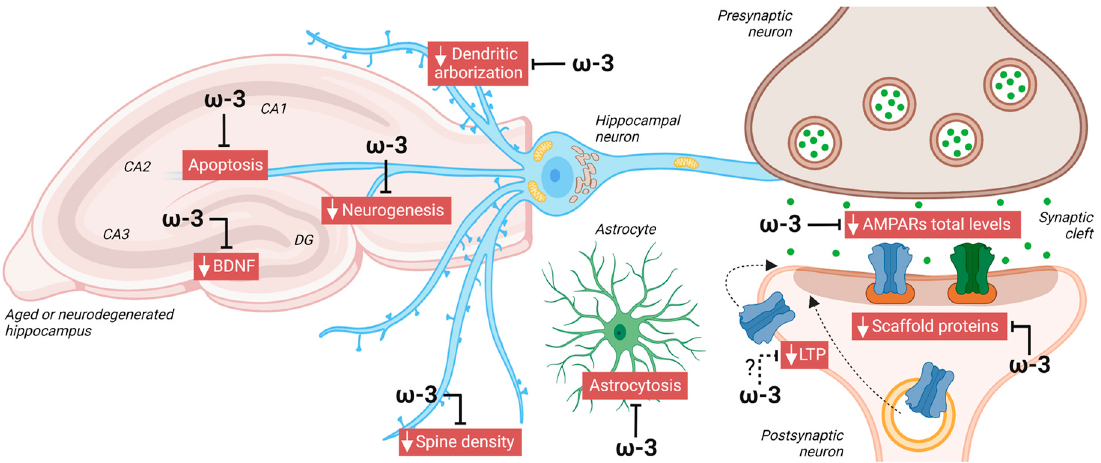
Figure 2. Protective role of omega 3 ( ω -3) against neurodegeneration. In animal models of aging or neurodegeneration, diet supplementation with ω -3 reduced apoptosis and astrocytosis, and enhanced neurogenesis, dendritic arborization, spine density, and levels of BDNF, AMPARs, and scaffold proteins, like postsynaptic density protein 95 (PSD95), in the HPC. The fact that ω -3 deficiency reduced LTP in aged mouse CA1-HPC suggests that ω -3 could also improve activity-dependent synaptic plasticity, contributing to its protective role in cognition. Image created with